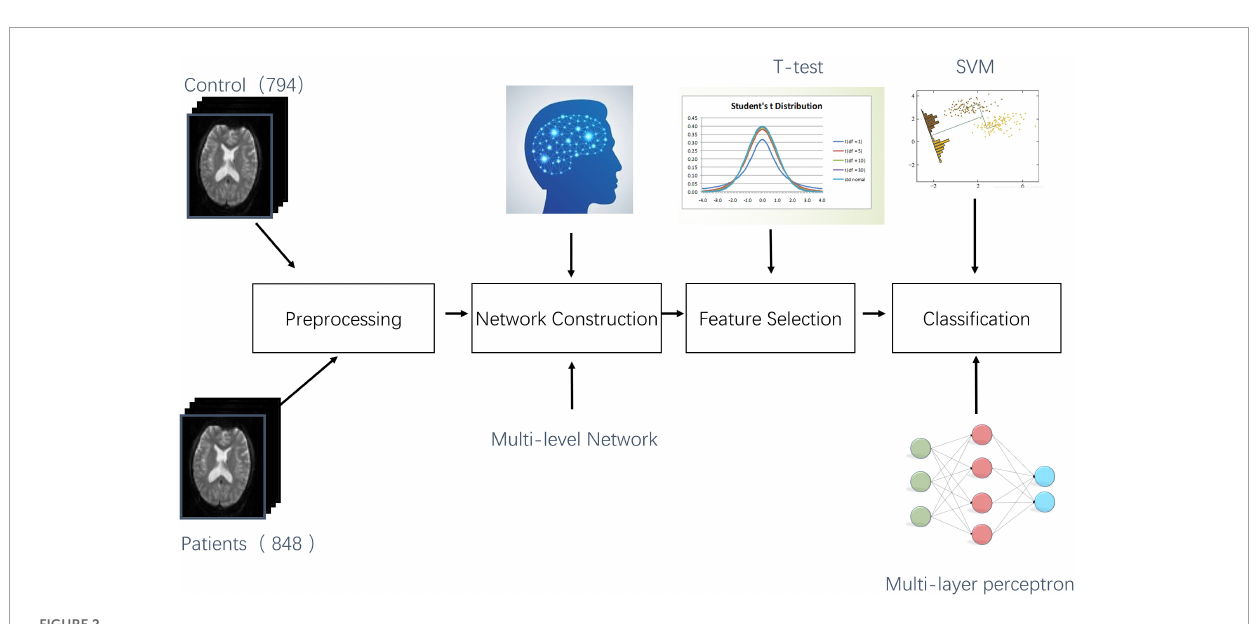
FIGURE2 Flow chart of the